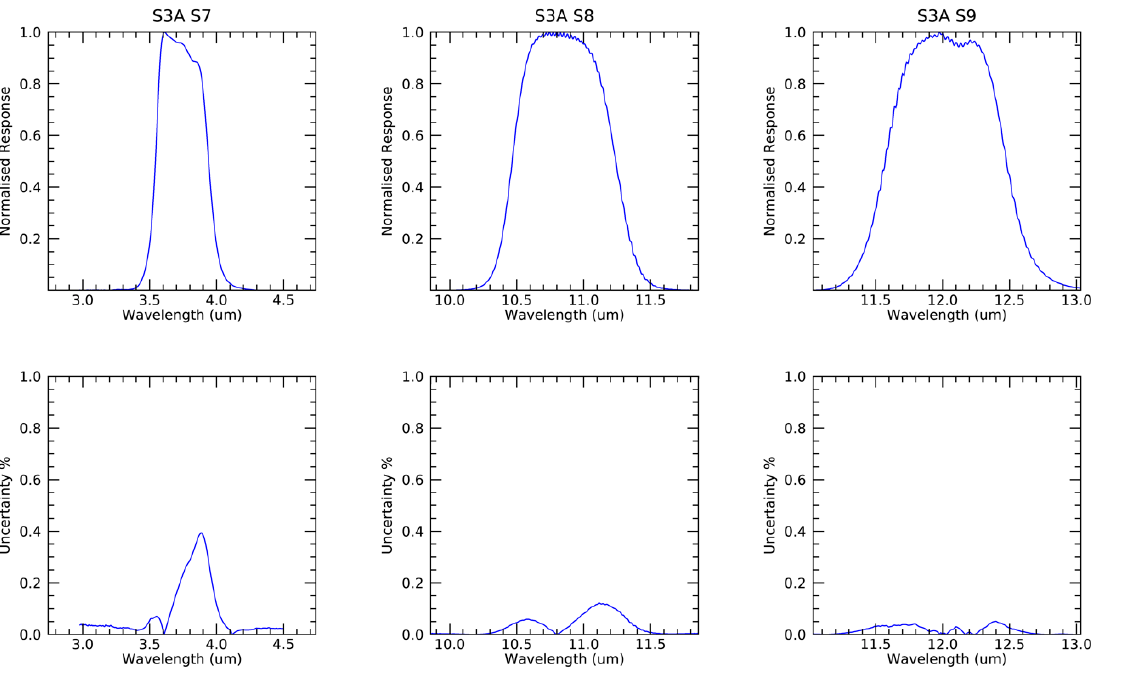
Figure 6. SLSTR-A Spectral Response Measurements for the TIR channels at 87 K [15]. Upper plots give spectral response functions, lower plots the associated systematic uncertainties.